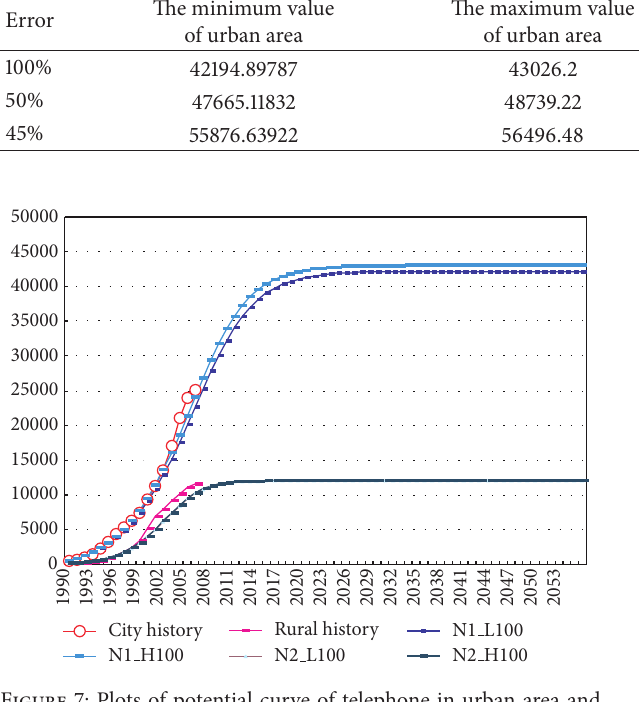
Figure 7: Plots of potential curve of telephone in urban area and rural area governed by model (68) (the control error rate is 100%).